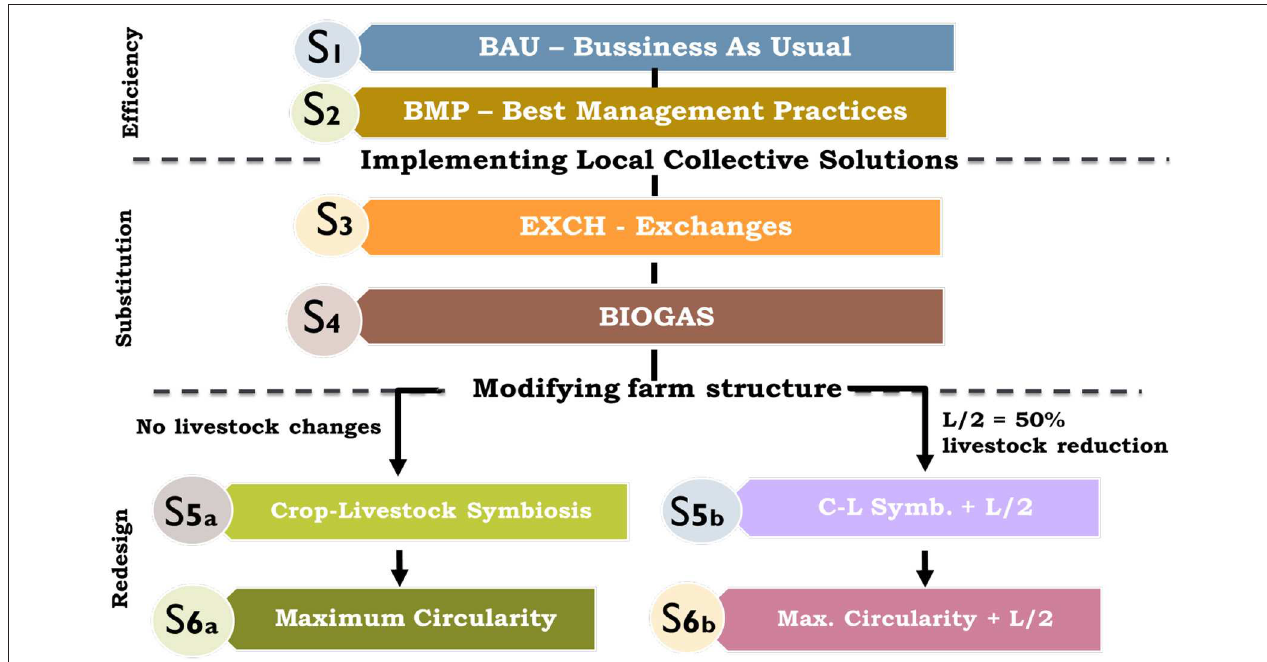
FIGURE 3 | Scenarios explored in the Ribéracois case study using the FAN model. The S5b scenario is Crop-Livestock Symbiosis and the S6b Scenario is Maximum Circularity. The scenarios are designed in an additive manner, i.e., each scenario applied the changes already implemented in the previous